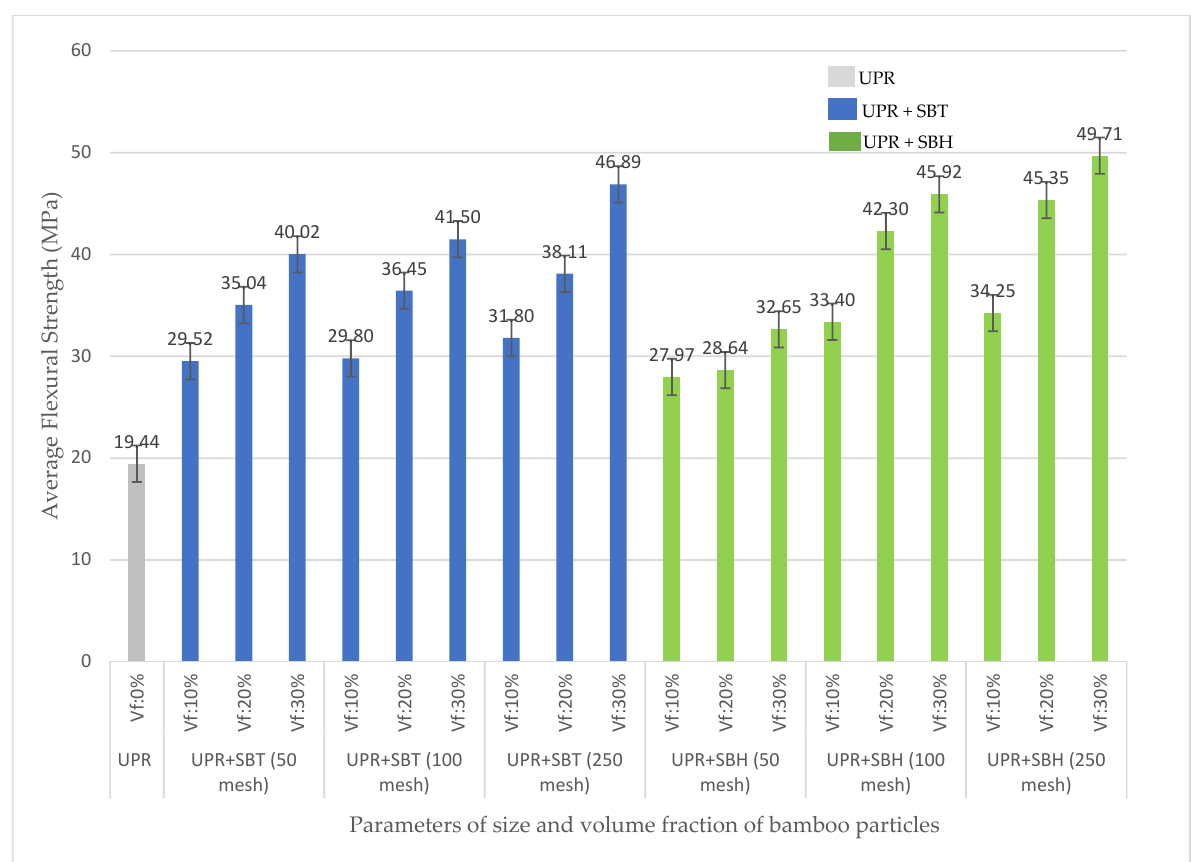
Figure 5. Relationship between UPR composite flexural strength to volume fraction and particle size of SBT and SBH.